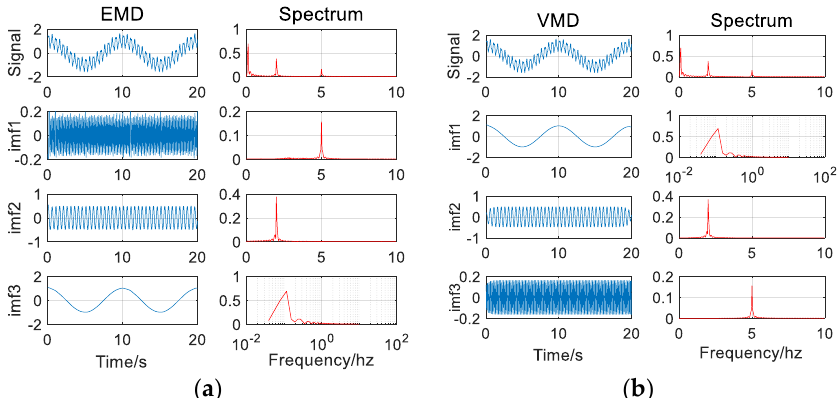
Figure 3. Signal waveform and corresponding spectrogram (without noise).